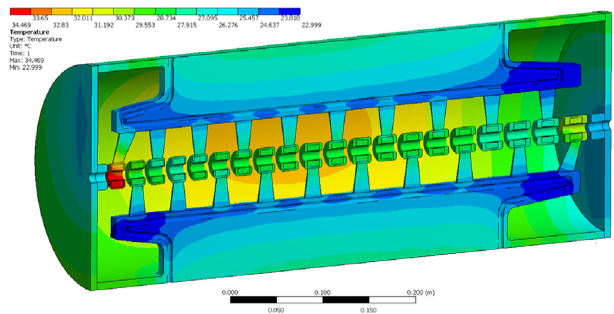
FIG. 16. Output of TRACE-3D envelope calculations for the IH1 tank.